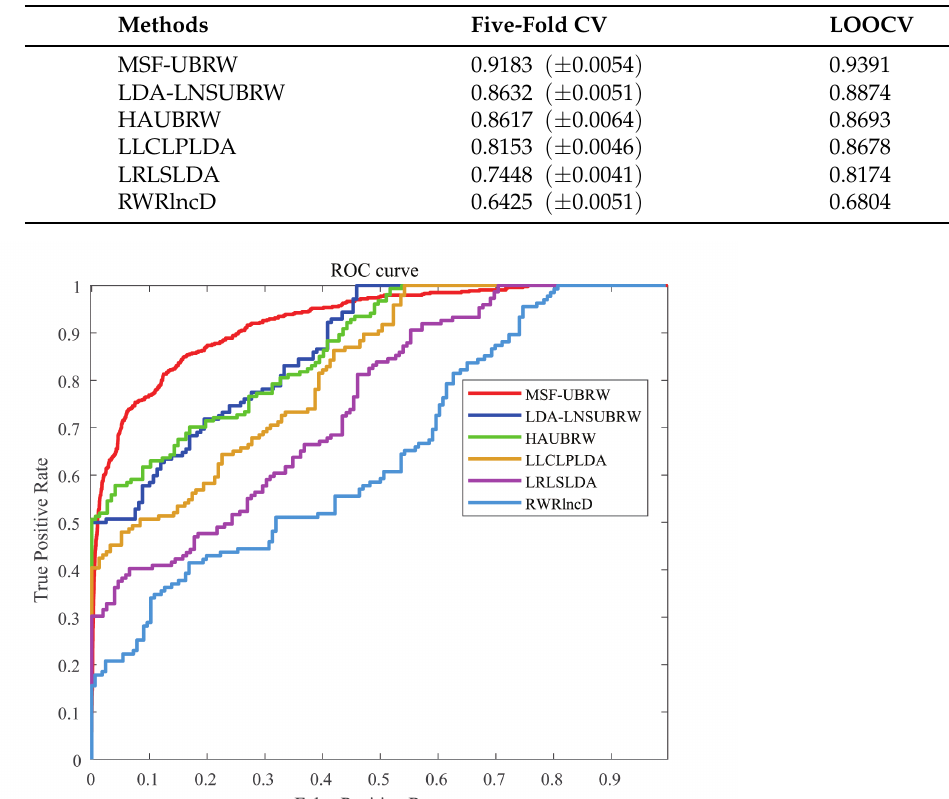
Figure 3. The ROC curves of the six methods (MSF-UBRW, LDA-LNSUBRW, HAUBRW, LLCLPLDA, LRLSLDA and RWRlncD) based on the 5-fold CV